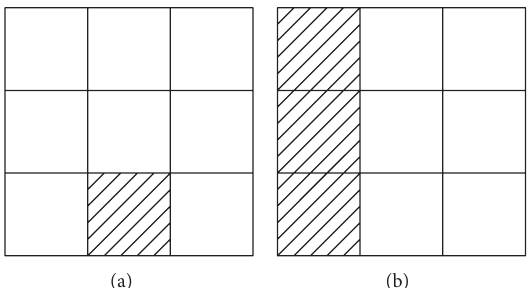
Figure 4: Neighboring voxels, to which each voxel needs access for voxel labeling. (a) Neighboring voxels in vertical labeling. (b) Neighboring voxels in horizontal